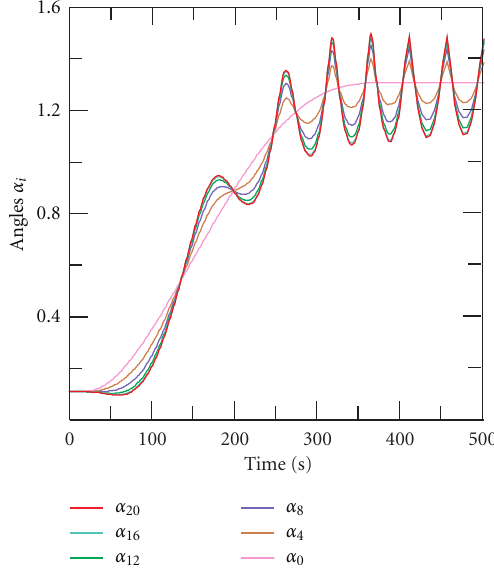
Figure 10: Time histories of absolute angular velocity projections.